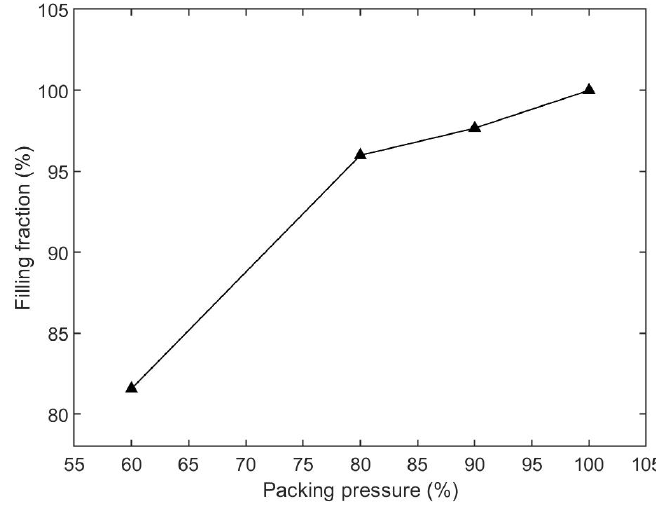
Figure 9. Relationship between the packing pressure and filling fraction, based on Table 6. Table 6. Processing parameters of the packing pressure study. Only packing pressure was changed.